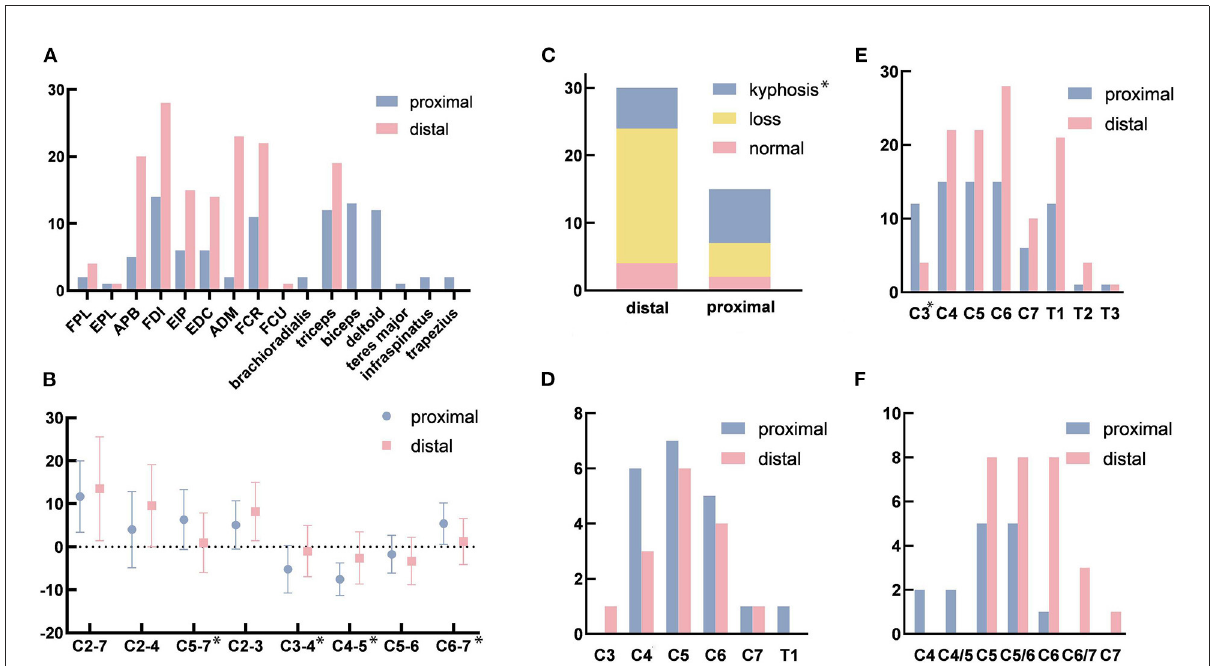
FIGURE2 (A) The affected muscles in electromyography (EMG). (B) The sagittal Cobb angle in different levels. (C) The changes in the cervical curvature. (D) The affected segments with high signal intensity on T2-weighted imaging (T2WI). (E) The affected segments with the loss of attachment. (F) The most serious segment with the loss of attachment. FPL, flexor pollicis longus; EPL, extensor pollicis longus; APB, abductor pollicis brevis; FDI, first dorsal interossei; EIP, extensor indicis proprius; EDC, extensor digitorum communis; ADM, adductor digiti minimi; FCR, flexor carpi radialis; FCU, flexor carpi ulnaris. * p < 0.05. Figure 2 was modified from Servier Medical Art (http://smart.servier.com/), licensed under a Creative Common Attribution 3.0 Generic License